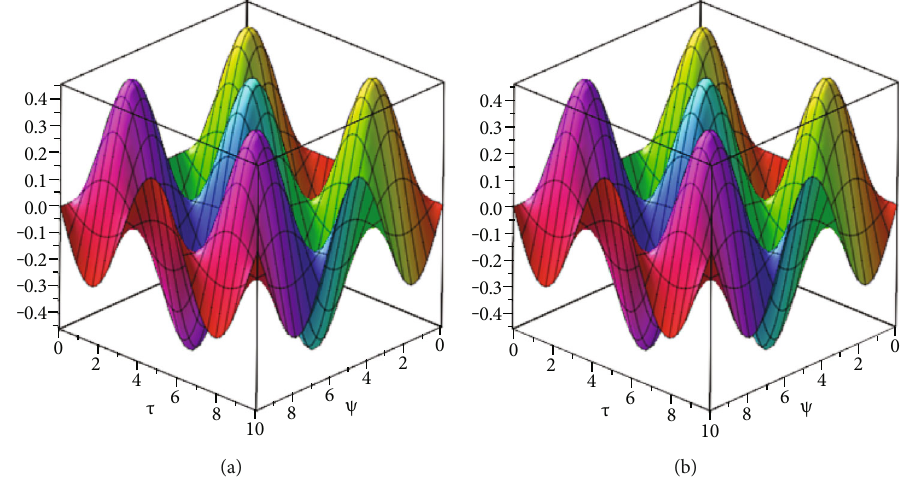
Figure 6: Example 4 solution graph. (a) Exact solution. (b) Analytical solution at σ = 1 .